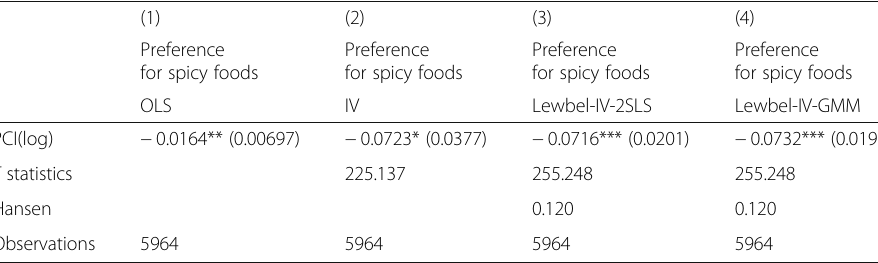
Table 5 Results of Lewbel ’ s IV